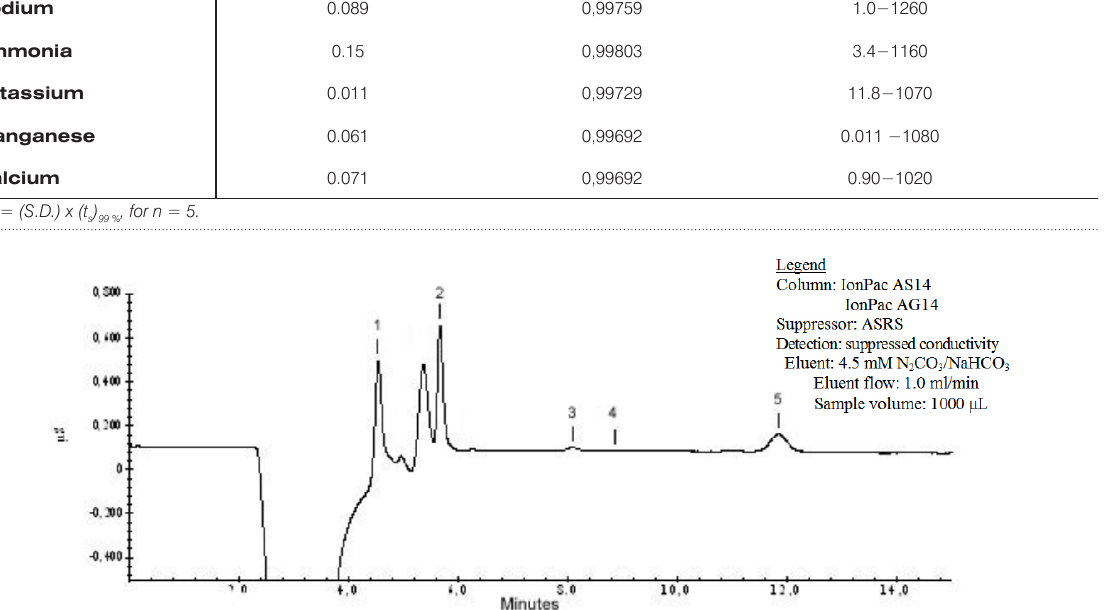
Figure 3. A representative chromatogram of anions corresponding to the SIC analysis of a condensed steam sample. Detected peaks: 1-fluoride, 2-chloride, 3-nitrate, 4-phosphate,